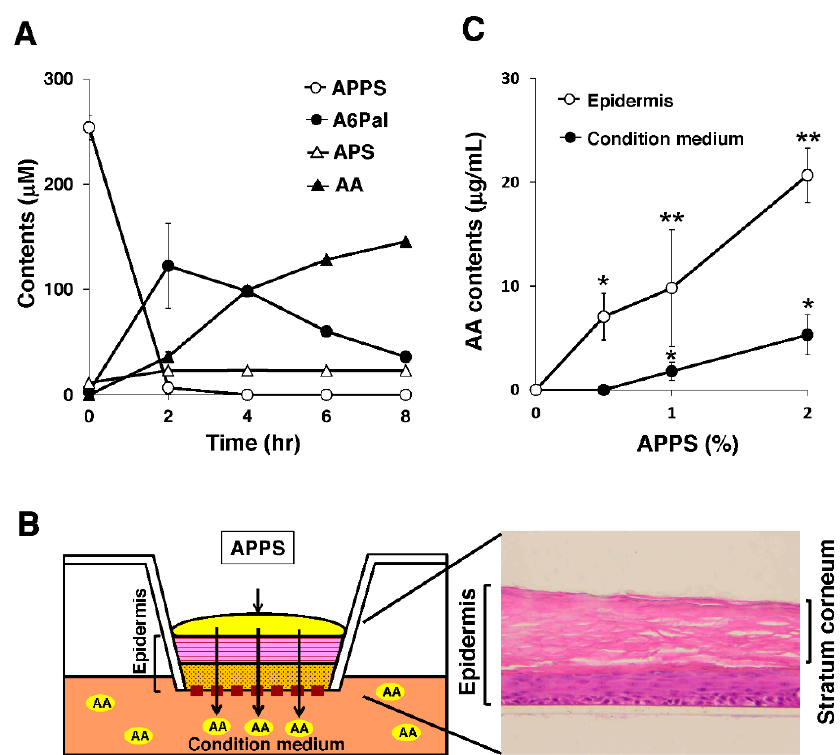
Figure 3. APPS is converted to AA by endogenous convertases. ( A ) A kinetics analysis of APPS metabolites including AA, A6Pal, and APS in keratinocyte lysates; ( B ) A human epidermal skin model (LabCyte EPI-MODEL) was used in ex vivo experiments; ( C ) AA contents in epidermis and conditioned medium in an ex vivo human epidermal skin model treated with APPS at various doses. These data represent the mean ± SEM; * p < 0.05 vs. no AA treatment, ** p < 0.01 vs. no AA treatment.